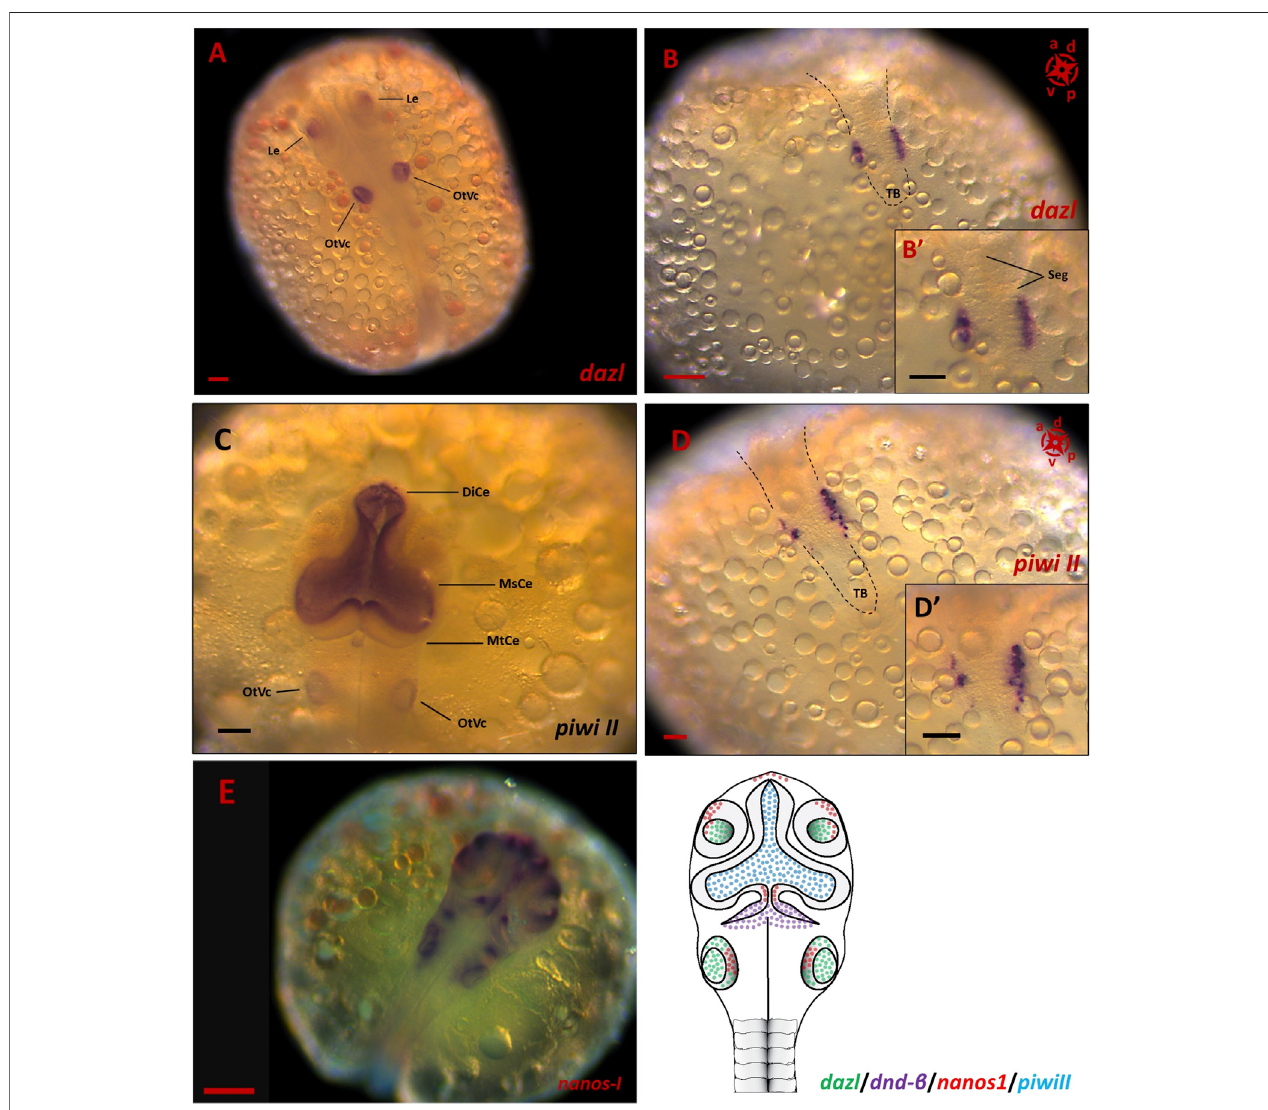
FIGURE4| ThespatialexpressionofPGCmarkersinembryonicstagesof G.holbrooki .WISHpanelsshowingspatialexpressionof dazl (A,B) , piwiII (C,D) and nanos1 (E) duringsomitogenesisin G.holbrooki .The dazl expression(n (cid:1) 5)wasdetectedinoticvesicle(OtVc)andopticlens(Le),anteriorly (A) andPGCclustersposteriorly (B) and closeupinset),inacloserproximitytotailbud(TB),rightinbothsidesofsegments(Seg).Inslightcontrast,theanteriorexpressionof piwiII (n (cid:1) 7)wasstronglydetectedinthe region of developing brain predominantly in diencephalon (DiCe) and mesencephalon (MsCe) with a very weak expression in otic vesicles. Whereas the posterior expression of piwi II was restricted tomigrating PGCs ( (D) and close up inset). The nanos1 expression was exclusively detected indeveloping brain and otic vesicle ofmid- somitogenesisembryos(n (cid:1) 6). Thecompass indicates theorientation ofdevelopingembryos where applicable.Theschematic (F) representsthesimultaneousexpression domains of PGC markers in CNS during somitogenesis. The black dashed lines indicate the location of embryonic body. The scale bars represent 100 µm.